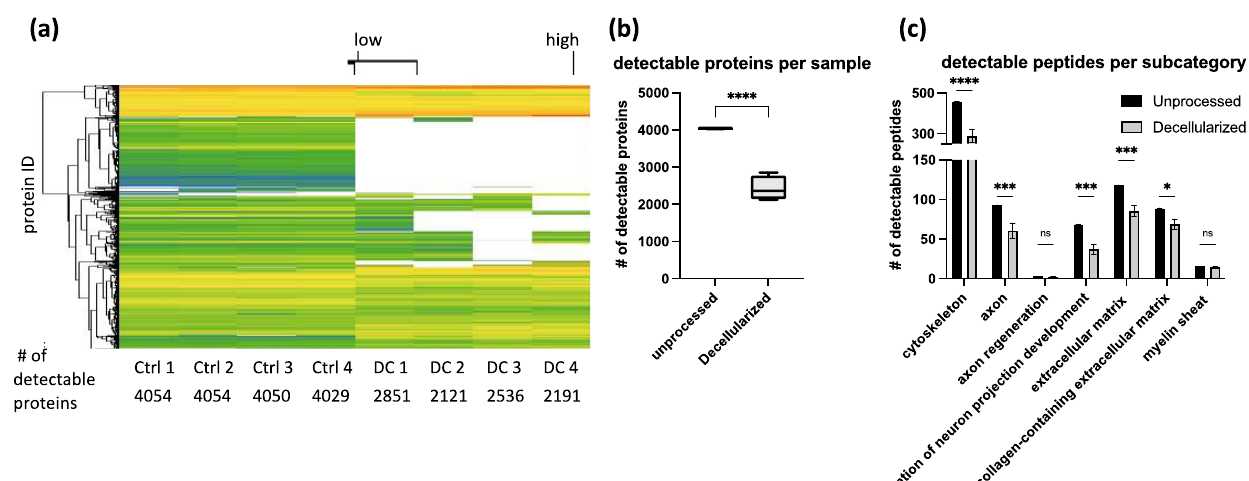
Figure 5. Peptide removal in acellular grafts. Each column represents the protein abundance of one replicate. Ctrl 1–4 are unprocessed samples. DC 1–4 are decellularized samples. ( a ) Heatmap. In total, 4054 proteins were measured. Each line represents one UniProt ID identifying one protein. green: high abundance of protein in the sample. White: low abundancy of protein in the sample. ( b ) Total number of proteins above detection limit. ( c ) Number of peptides per subcategory. Subcategories defined by AmiGO2 GO class for sus scrofa and UniPort as contributor. The bar plot shows the number of detectable peptides in all replicates in chosen subcategories (cytoskeleton, axon-, axon regeneration, regulation of neuron projection development-, ECM-, collagen-containing ECM, myelin sheath associated peptides). For statistical analysis, Two-way ANOVA was performed. Adjusted p -value: <0.0001 = ****, p < 0.001 = ***, p < 0.01 = **, p < 0.05 = * ns: no significant differences.